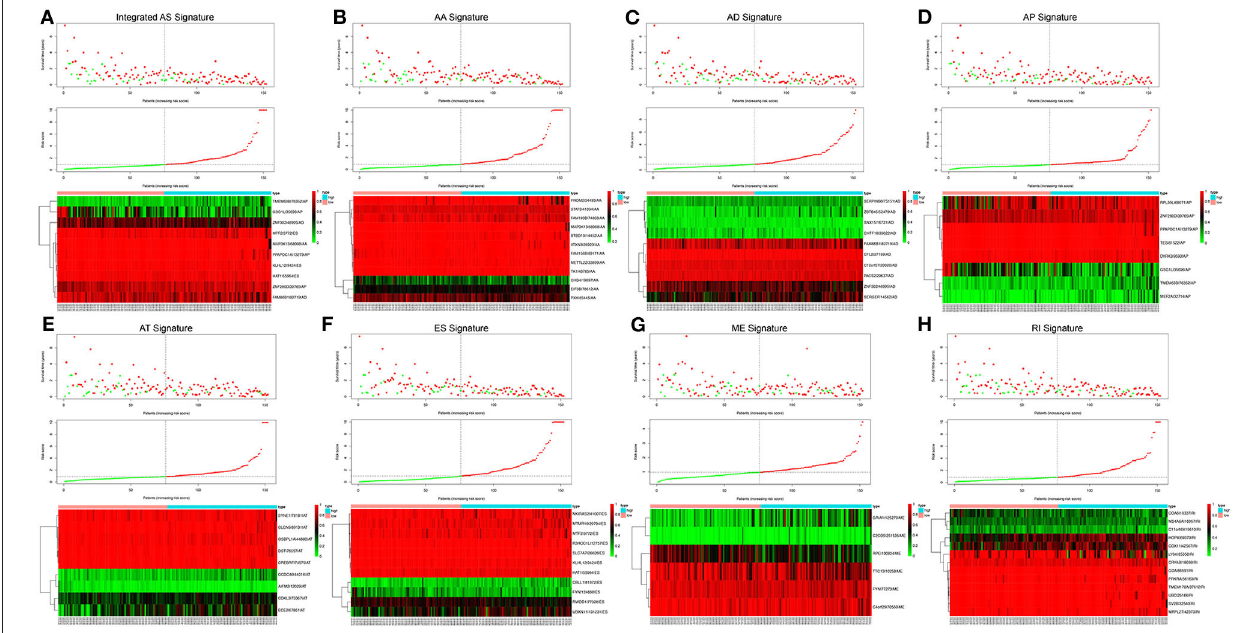
FIGURE 4 | Risk score analysis of the integrated AS signature and the 7 type-specific AS signatures in GBM patients. Upper panel (A–H) Patient survival status and time distributed by risk score. Middle panel (A–H) Risk score curve of the AS signature. Bottom panel (A–H) Heatmaps of prognosis-related AS events. Colors ranging from green to red indicate expression levels ranging from low to high. The dotted line represents the individual inflection point of the risk score curve, by which the patients were categorized into low-risk and high-risk